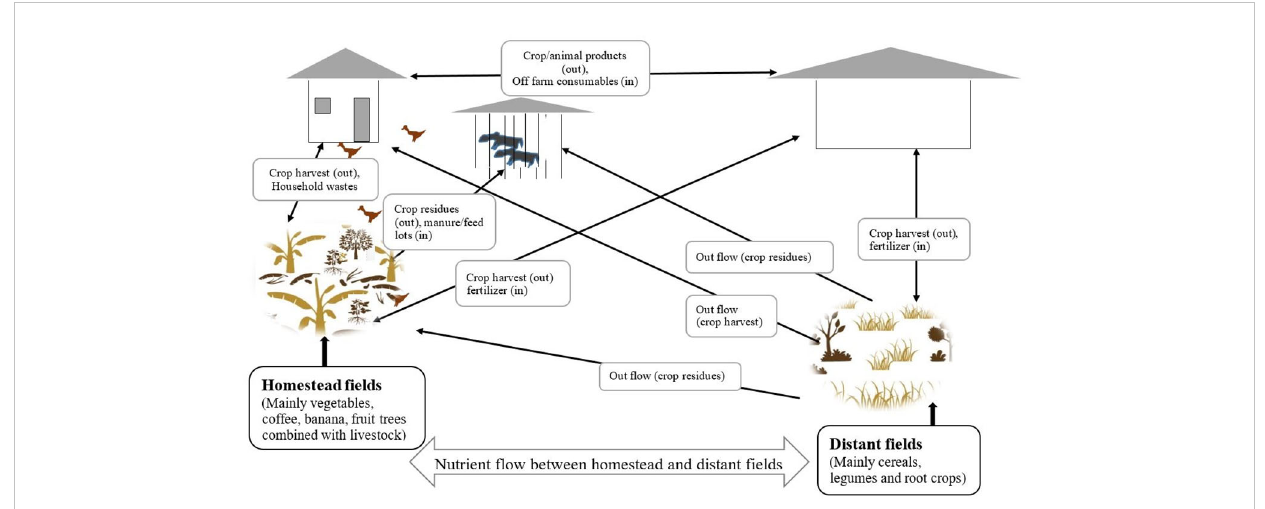
FIGURE 3 A schematic representation of nutrient fl ow between, within, and outside homesteads and distance